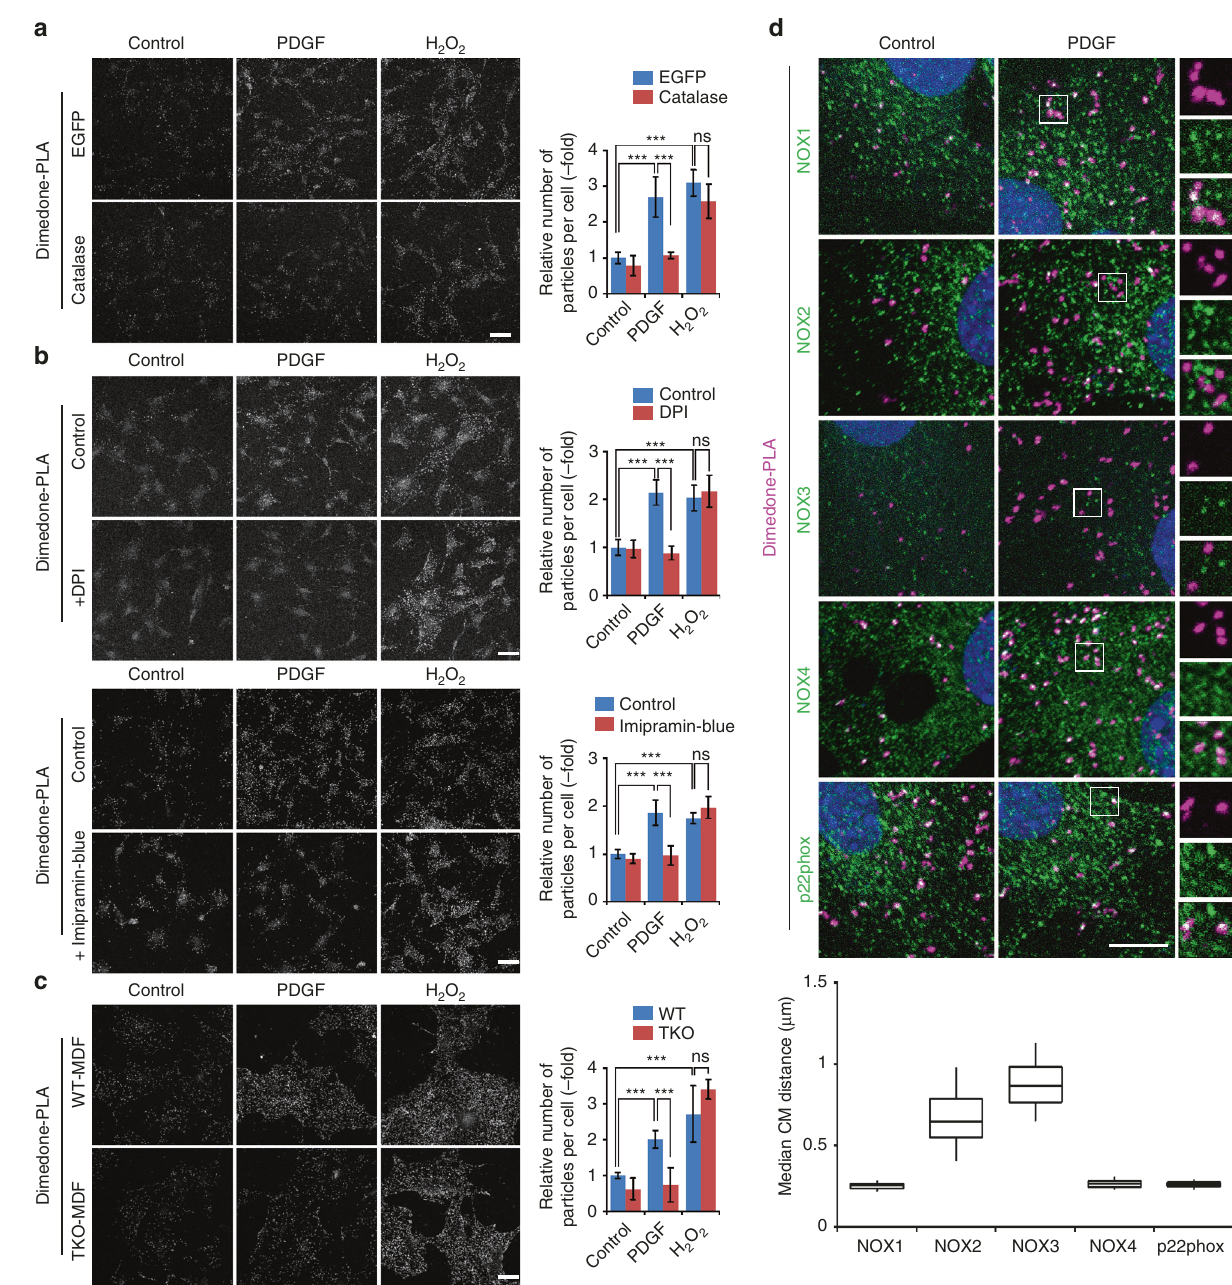
Fig. 4 NOX complexes catalyze PDGF-evoked SHP2 oxidation. a Serum-starved Swiss 3T3 cells expressing EGFP or cytoplasmic catalase were stimulated with PDGF-BB (50 ng ml − 1 ) or H 2 O 2 (1 mM) for 10 min and subjected to dimedone-PLA ( gray ). Representative images are shown for each condition from one of two independent experiments. b Serum-starved Swiss 3T3 cells were left untreated or were pre-treated with DPI (2.5 μ M) ( top ) or imipramine-blue (6 μ M) ( bottom ) for 5 min, stimulated with PDGF-BB (50 ng ml − 1 ) or H 2 O 2 (1 mM) for 10 min and subjected to dimedone-PLA ( gray ). Representative images are shown for each condition from one of two independent experiments. c Serum-starved primary murine dermal fi broblasts ( MDFs ) from wild type (WT) or Nox1, 2, 4 triple-KO (TKO) mice were stimulated with PDGF-BB (50 ng ml − 1 ) or H 2 O 2 (1 mM) for 10 min and subjected to dimedone-PLA ( gray ). Representative images are shown for each condition from one of three independent experiments. a – c The graphs show the average number of PLA signals per cell ( n = 6 images for each condition, 5 – 15 cells in an image), relative to control cells (normalized to 1). Error bars represent SD. *** P < 0.0001, ns not signi fi cant, ANOVA with Bonferroni/Dunn ’ s post-hoc test. Scale bar : 50 μ m. d Serum-starved Swiss 3T3 cells were stimulated with PDGF-BB (50 ng ml − 1 ) for 10 min, and fi xed in the presence of dimedone. Representative co-staining of ox-SHP2, detected by dimedone-PLA ( magenta ), and the indicated NOX components ( green ) are shown from one of three independent experiments ( top ). Nuclei were stained with DAPI ( blue ). Higher magni fi cation images of the boxed regions are shown. Scale bar : 10 μ m. Median distances of centers of mass ( CM ) between punctate signals of ox-SHP2 and the nearest indicated NOX protein signal in cells were obtained by object-based image analysis. Box-whisker plots show median distances at 10 min after PDGF stimulation ( n = 50 cells). Boxes represent the 25th – 75th percentiles and whiskers the 5th – 95th